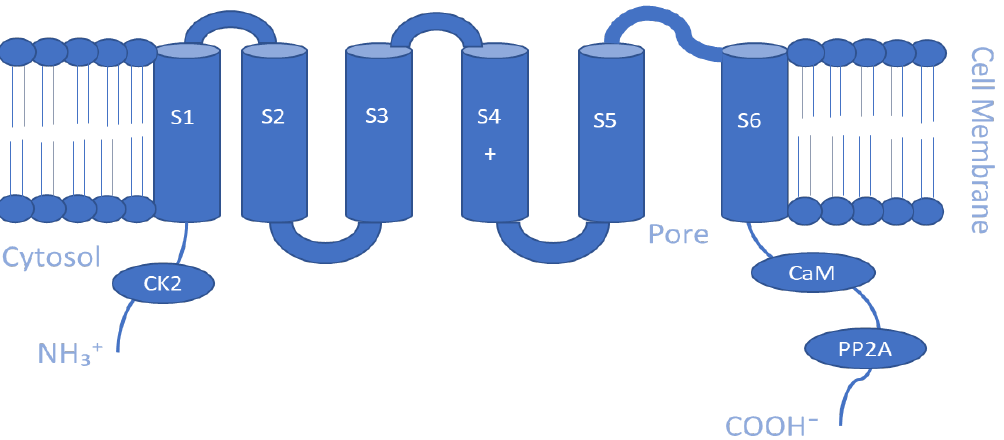
Figure 2. Schematic representation of the transmembrane (TM) topology of big-conductance K channel (BK) subunits containing seven TM segments with the pore region formed by S5 and S6 segments. The two regulators of K conductance (RCK) domains are in the C-terminus, with Ca 2+ bowl in RCK2.